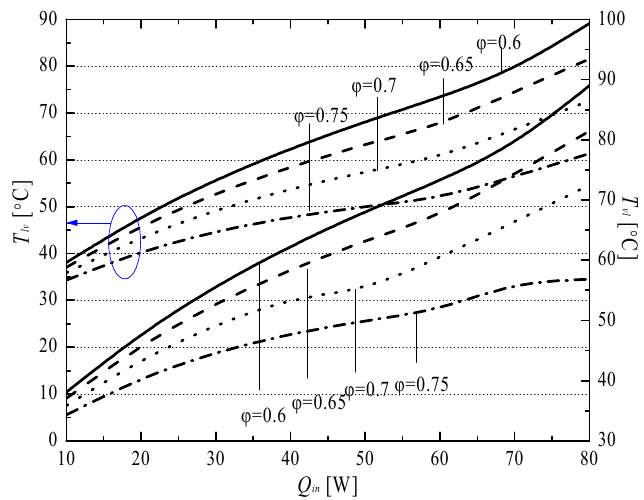
Figure 12. Variations in T lv and T vl with input thermal load for different porosities.